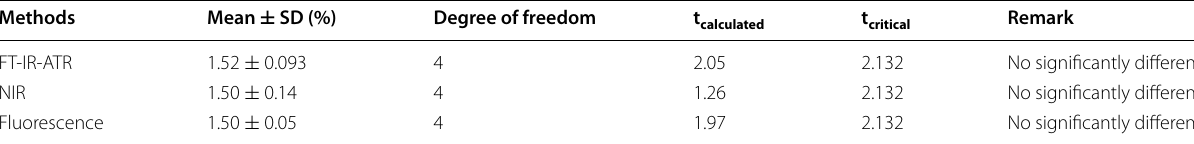
Table 3 Comparison of the means of each of the three newly developed methods with the mean obtained by UV/Vis spectrophotometer using t test at 95% confidence